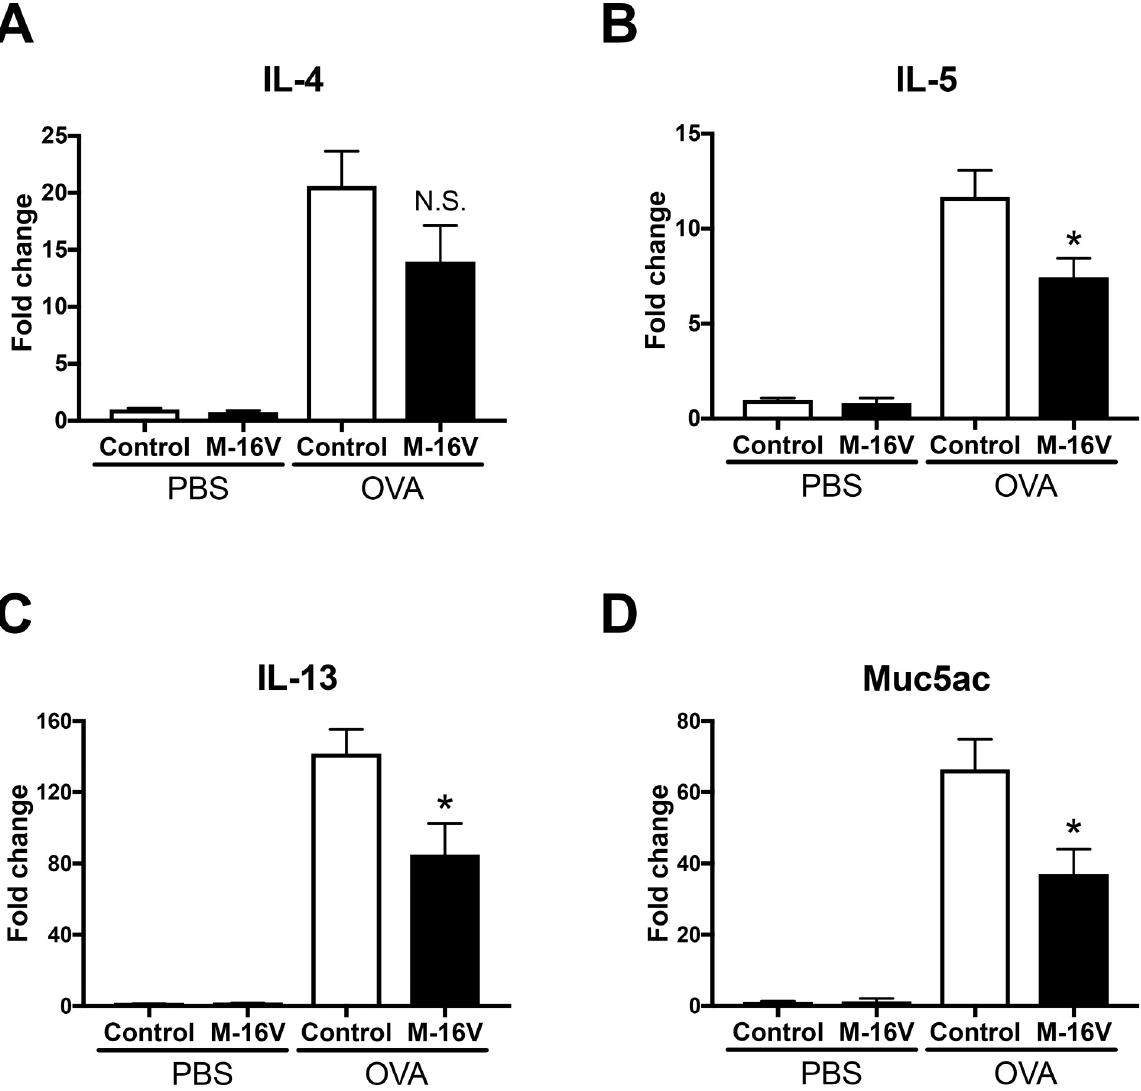
Fig 3. Effect of M-16V feeding on the expression of bronchial asthma-related genes. mRNA levels of IL-4 ( A ), IL-5 ( B ), IL-13 ( C ), and Muc5ac ( D ) in lungs were determined by real-time PCR. The values are presented as the means ± SEM (n = 6–21). � P < 0.05, �� P < 0.01, compared with OVA-sensitized and -exposed mice with a control